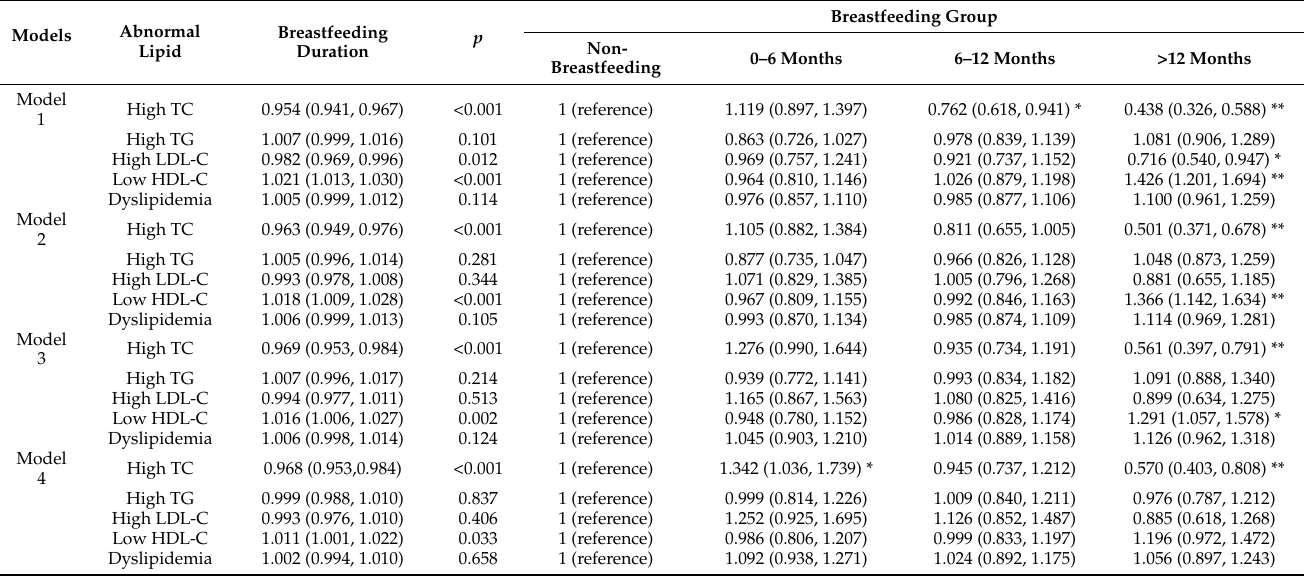
Table 3. Logistic regression analysis of breastfeeding duration and abnormal lipid risk, OR (95%